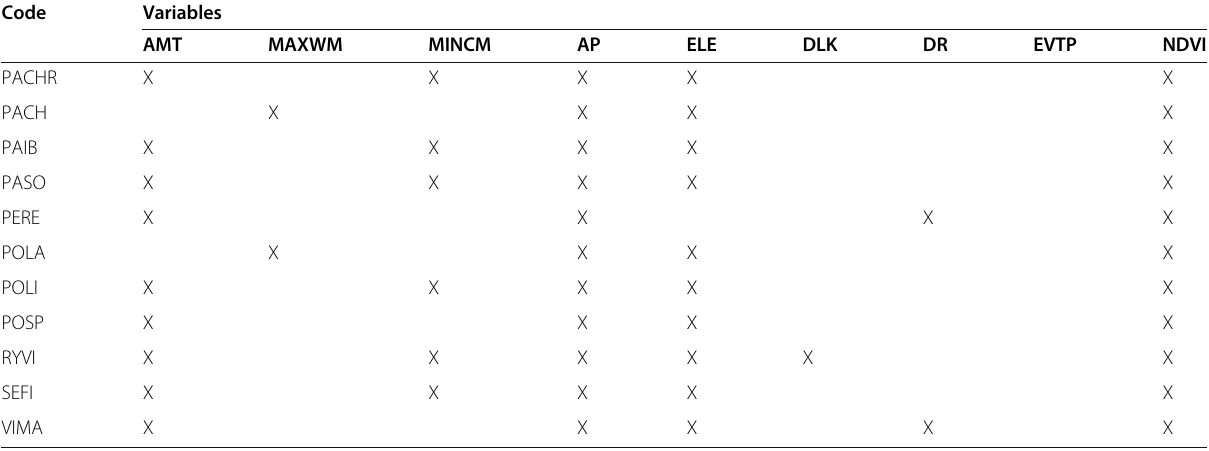
Table 4 Environmental variables used for each plant species modelling of the potential habitat suitability in Santa Cruz Province (Continued)